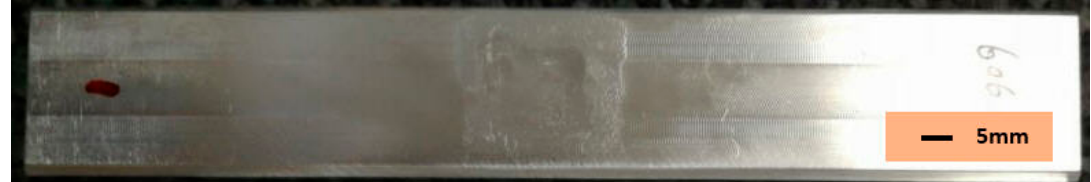
Figure 11. Geometry of the unrepaired (baseline) specimen–units are in mm.